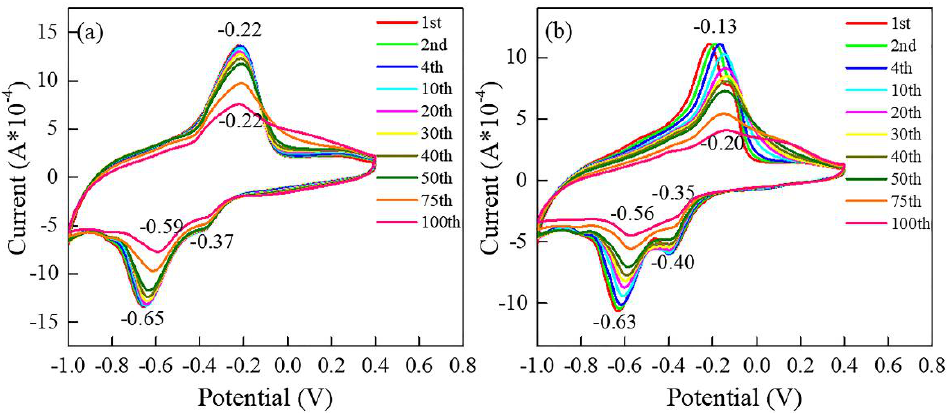
Figure 7. Cycling behaviors of the film-working electrodes at scan rate of 10 mV s −1 : N − 400 ( a ); N − 450 ( b ). N − 450 ( b